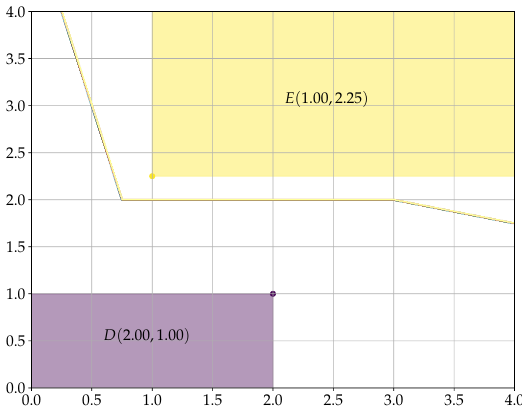
Figure 1. The purple and the yellow regions corresponds respectively to the sets E ( 1,2.25 ) and D ( 2,1 ) . The piece-wise linear curve corresponds to the decision boundary of the DEP classifier with β =